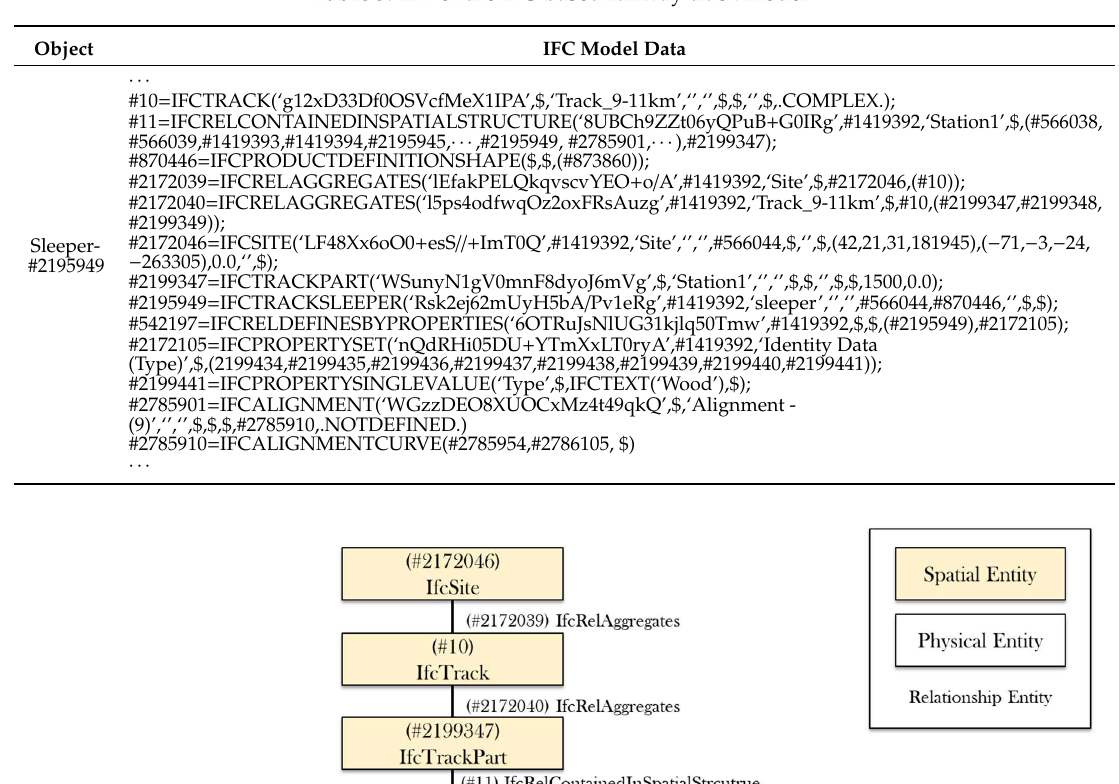
Table 3. IPF of the IFC-based railway track model.